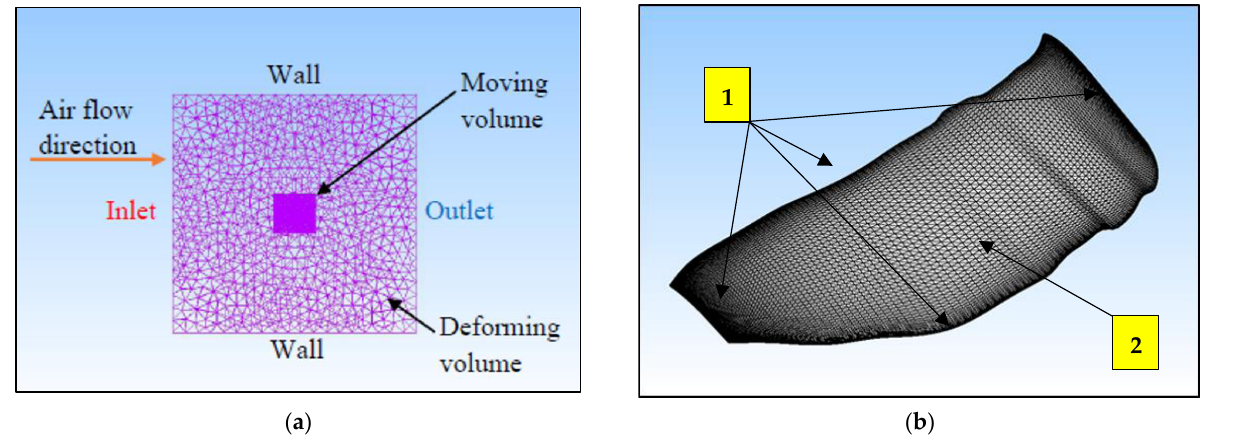
Figure 5. ( a ) Mesh modeling description of the wing for numerical analysis; ( b ) variation of lift coefficient with time step at various flapping frequencies.